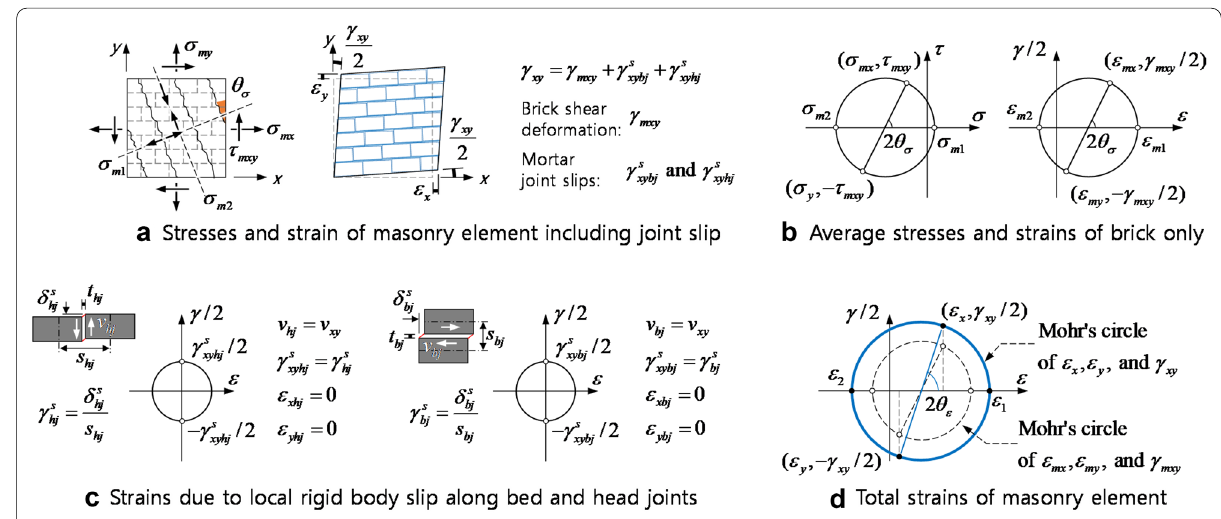
Fig. 2 Disturbed stress field model for unreinforced masonry